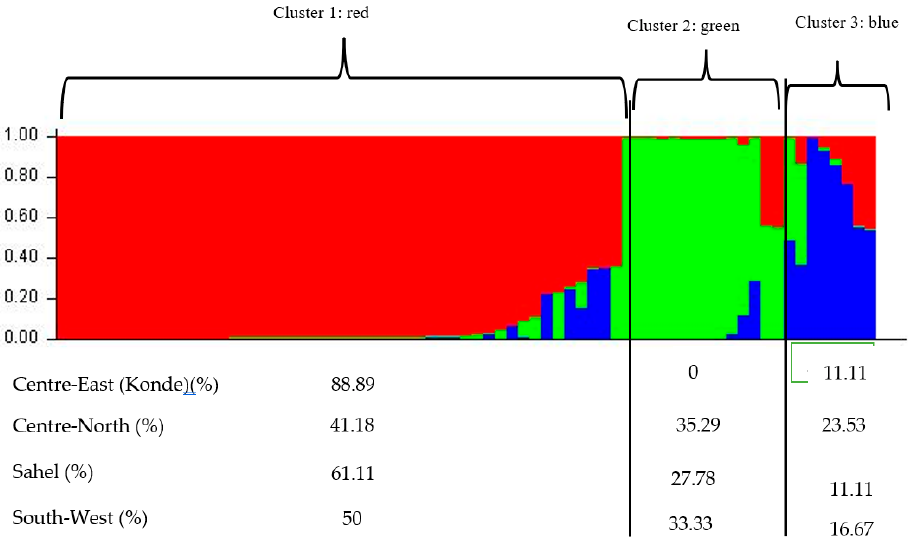
Figure 5. Genetic structure of four local chicken ecotypes from the Centre-East (Konde ecotype), Centre-North, Sahel and South-West regions of Burkina Faso.